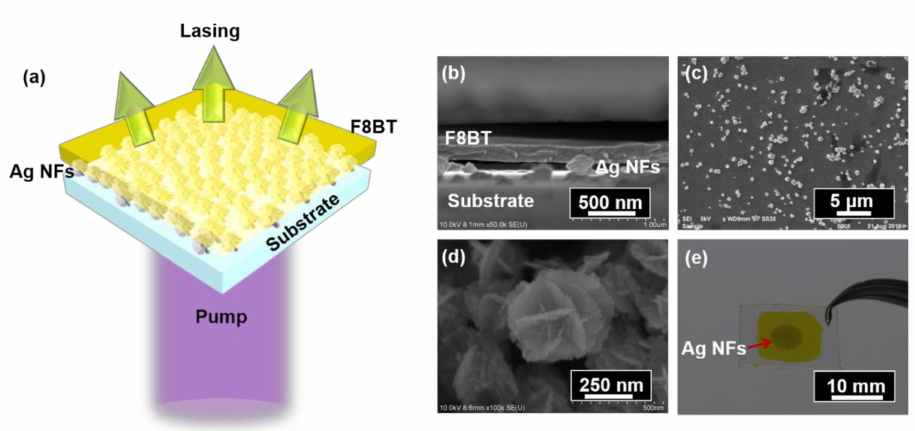
Figure 1. ( a ) Schematic of the proposed random laser. ( b ) Side-view SEM image of the random laser. ( c ) Top-view SEM image of the Ag NFs structure. ( d ) SEM image of Ag NFs at high magnification. ( e ) Photograph of the random laser. The red arrow indicates the Ag NFs